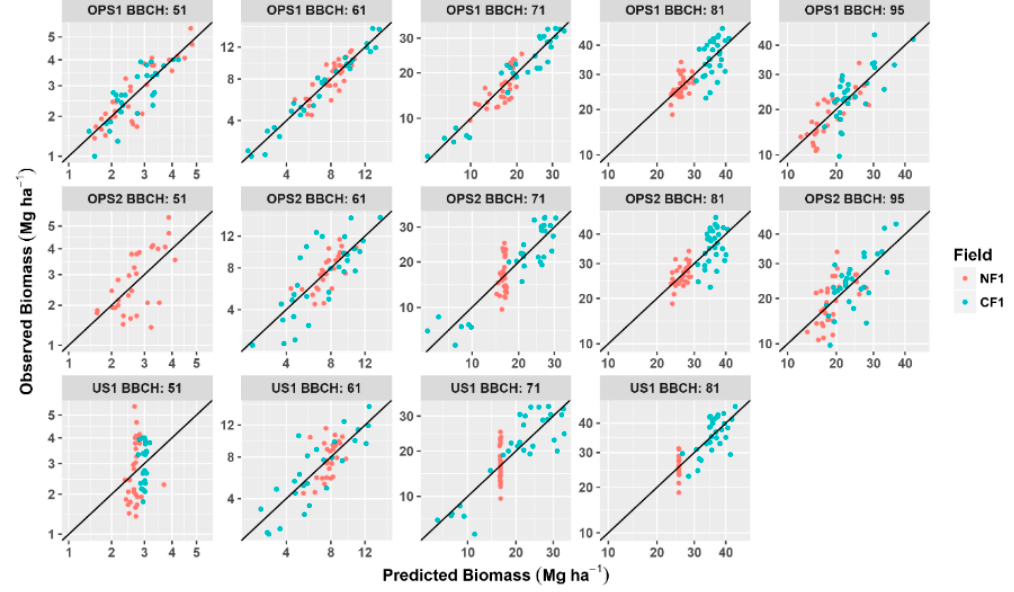
Figure A2. Crop aboveground fresh biomass prediction in five crop stages according to BBCH scale using three crop sensors: optical sensor 1 (OPS1: N-Sensor); optical sensor 2 (OPS2: Crop Circle); ultrasonic sensor 1 (US1: Polaroid), for cotton cultivated in two systems: narrow row (NF1) and conventional row spacing (CF1).